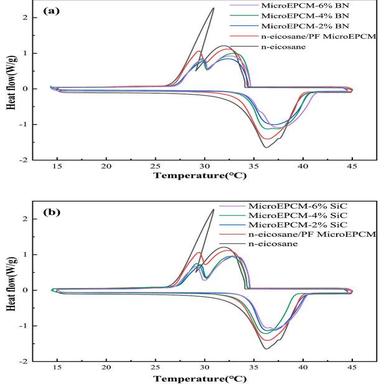
DSC curves of (a) MicroEPCM-BN; (b) MicroEPCM-SiC.